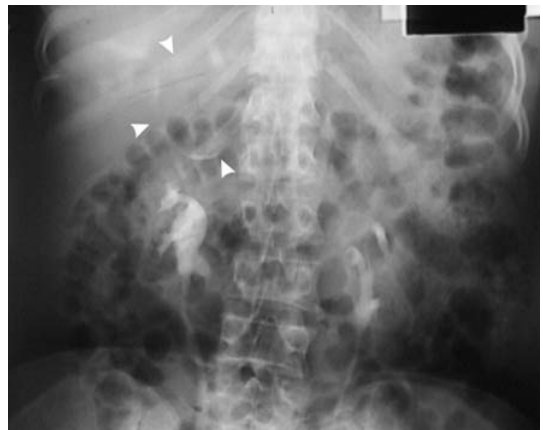
FIGURE 1 . Intravenous urography showing curvilinear calcifications in the left suprarenal region (arrowheads).